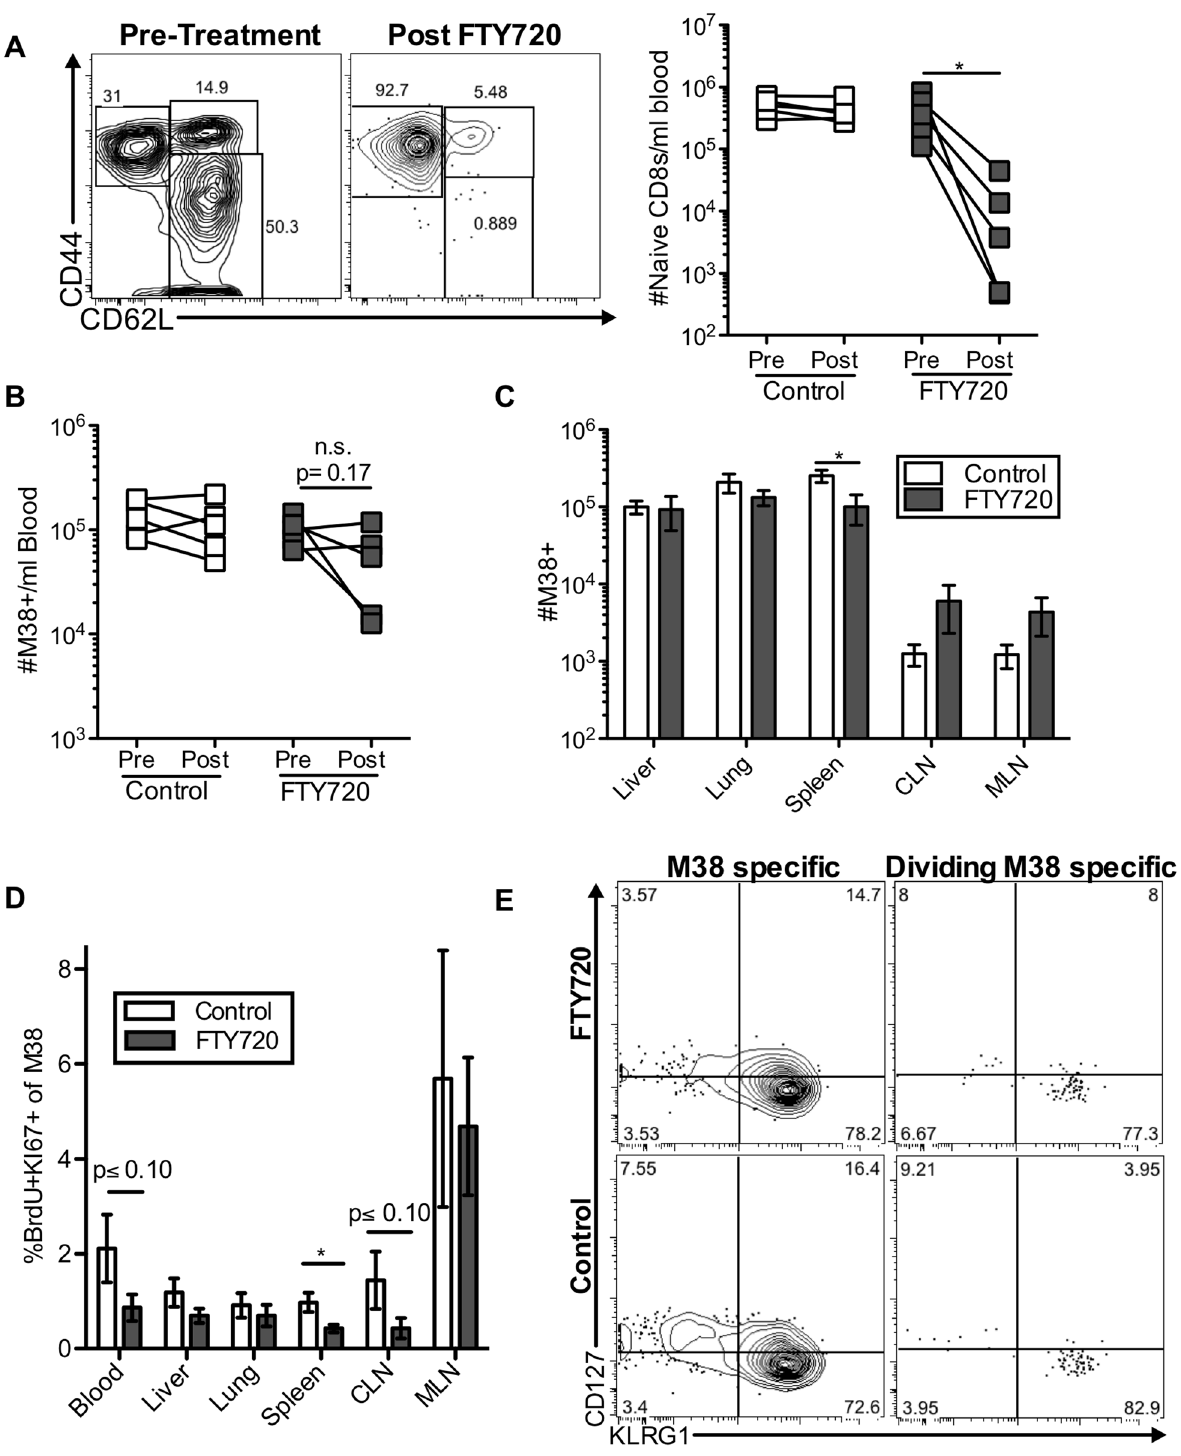
Figure 3. Short-term FTY720 treatment does not alter the pattern of division of inflationary cells. Mice chronically infected with K181 were treated with FTY720 for one week and then injected with BrdU 16 hours before sacrifice. (A) Naı¨ve T cells are lost from the blood during FTY720 treatment. The representative FACS plots show the expression of CD44 and CD62L on blood-localized CD8 T cells before (left) and after (right) FTY720 treatment. The graph shows the number of naı¨ve CD8s per milliliter of blood in control and treated mice before and after the treatment. Each line represents an individual mouse (n=5 per group). (B) M38-specific T cells are only slightly reduced with FTY720 treatment in some mice. Shown is the number of M38-specific CD8s per milliliter of blood in control and treated mice before and after the treatment period. (C) FTY720 treatment has a minimal effect on M38-specific CD8 T cells associated with various organs. Shown are the absolute numbers of M38-specific CD8 T cells harvested with the indicated organs of control (white) and FTY720 treated (grey) mice. (D) Dividing M38-specific T cells are detected systemically even after FTY720 treatment. Shown is the frequency of M38-specific CD8s associated with the indicated organs that were Ki67-positive and labeled with BrdU.